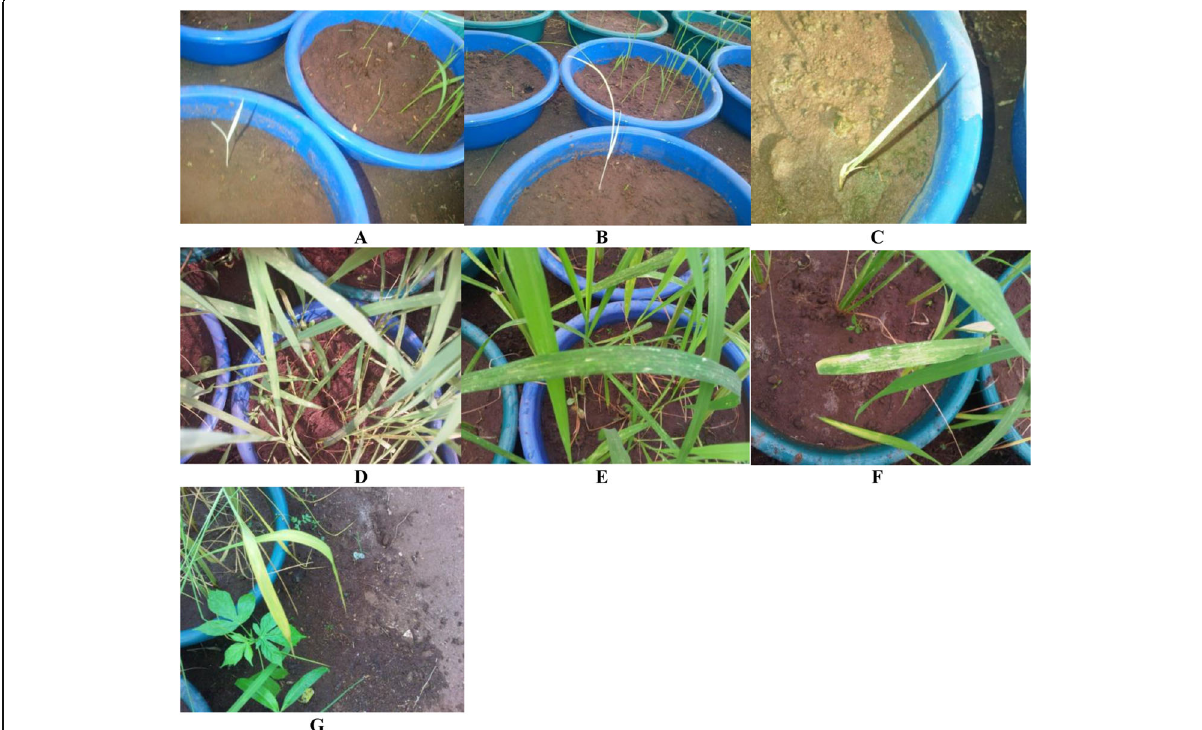
Fig. 6 Chlorophyll mutations in M 2 . a Albino mutation in NERICA L-47 at 1 WAP. b Albino mutation in NERICA L-47 at 2 WAP. c Albino mutation in NERICA L-34. d Striata mutation in FARO-44. e Striata mutation in FARO-52. f Striata mutation in FARO-57. g Viridis mutation in